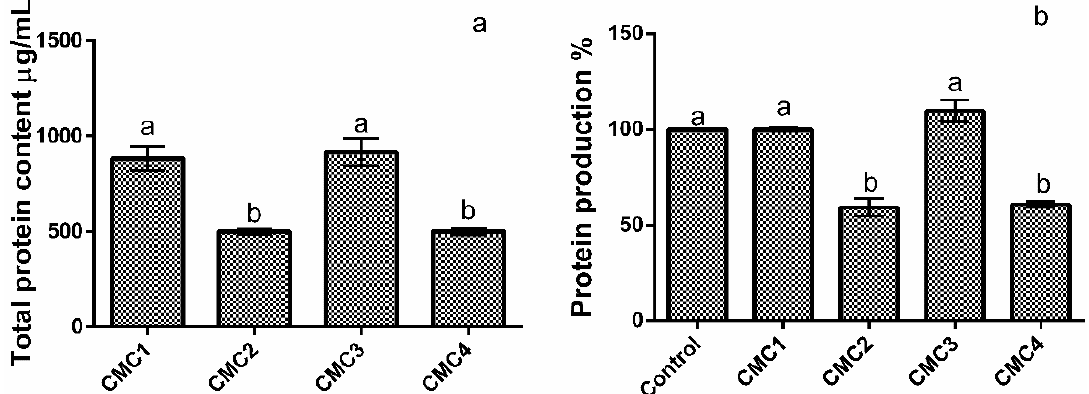
Figure 4. Total protein content of HDFa cells in the presence of CMC. ( a ) Total protein content; ( b ) percentage of protein production relative to the basal level (control). Different letters represent the statistically significant differences ( p < 0.05) found between conditions.